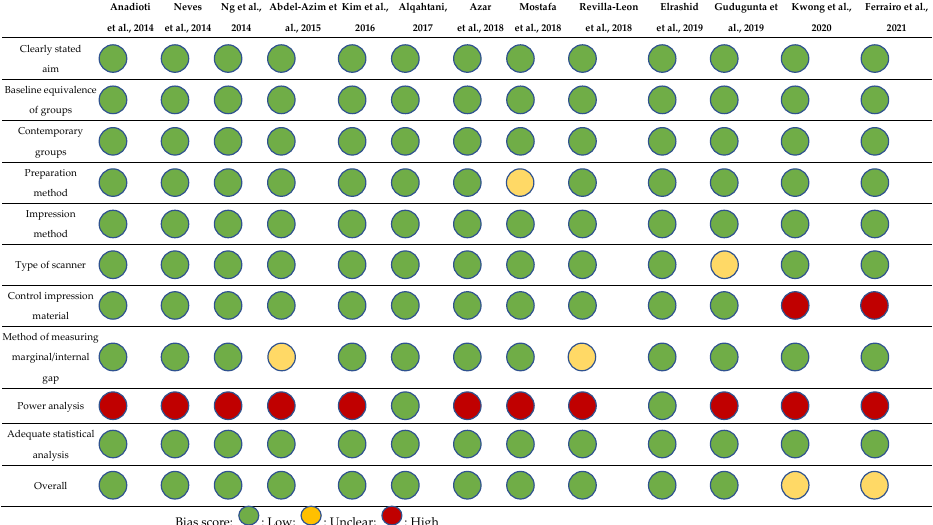
: High Figure 4. Risk of bias summary graph of included studies. Figure 4. Risk of bias summary graph of included studies.